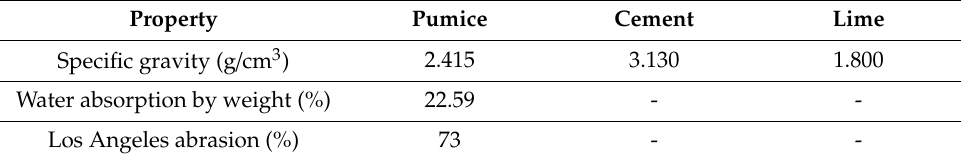
Table 3. Physical and mechanical properties of pumice, cement, and lime.